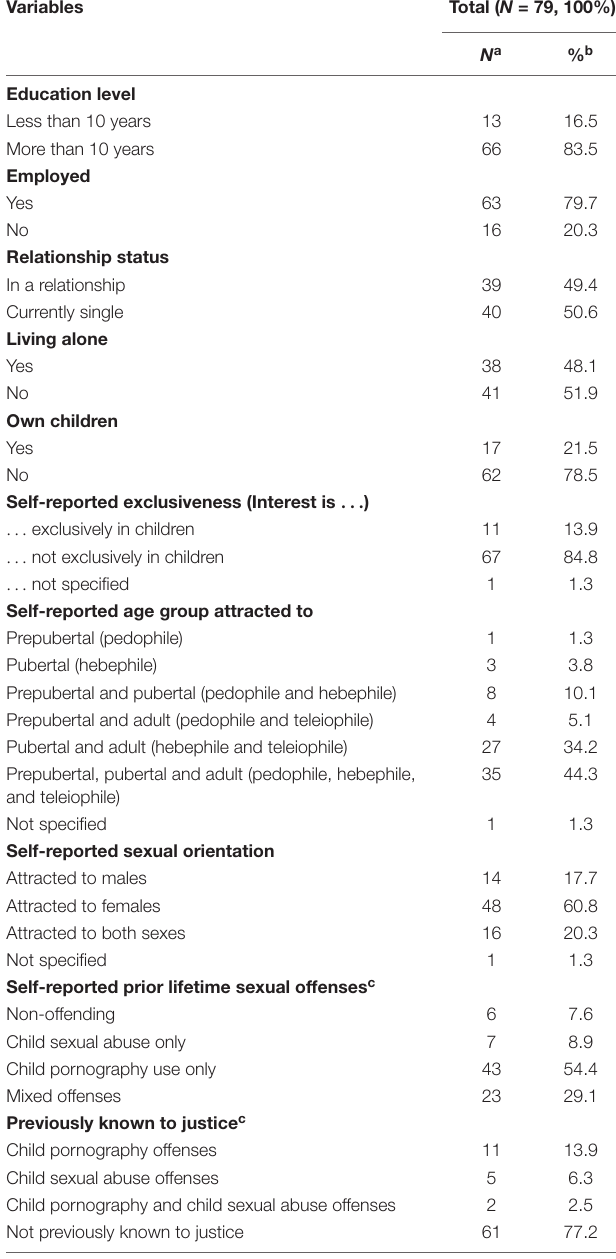
TABLE 1 | Sample characteristics for the total sample ( N = 79) when undergoing initial diagnostic